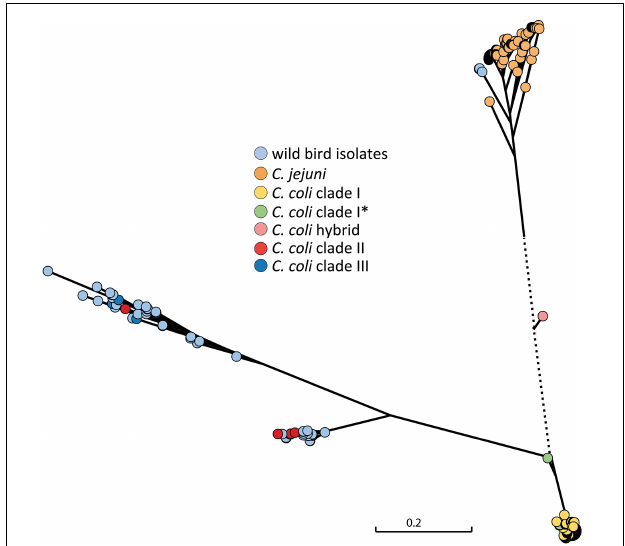
FIGURE 4 | Phylogenetic tree of the ceuE target gene for C. coli species differentiation. ceuE of C. coli clade I, for which typing methods have been optimized, is significantly different to clade II and clade II C. coli ceuE . The C. coli hybrid isolate in between C. jejuni and C. coli clade I was originally detected by ambiguous real-time PCR results which were caused by C. jejuni introgression into the C. coli genome (Golz et al., 2020). The scale bar represents the distance between the sequences determined by the number of SNPs. Dotted line is out of scale. *,